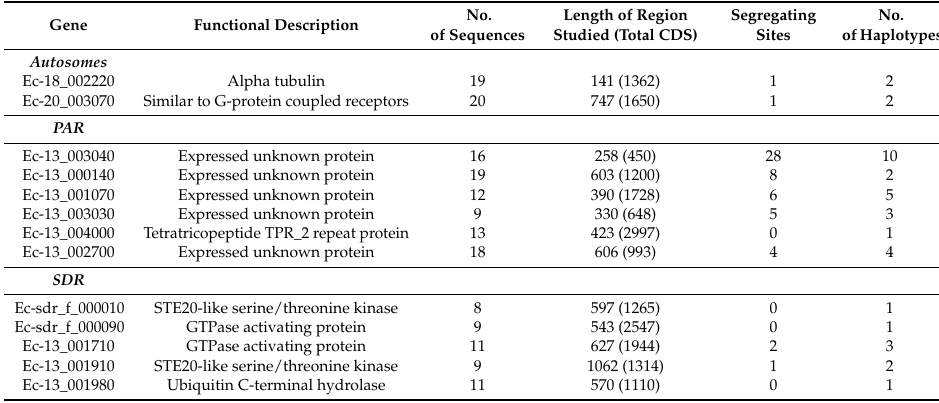
Table 1. Selected autosomal, pseudoautosomal regions (PAR) and sex-determining region (SDR) genes analyzed in this study. In brackets after the length of the studied region, is the total length of the coding